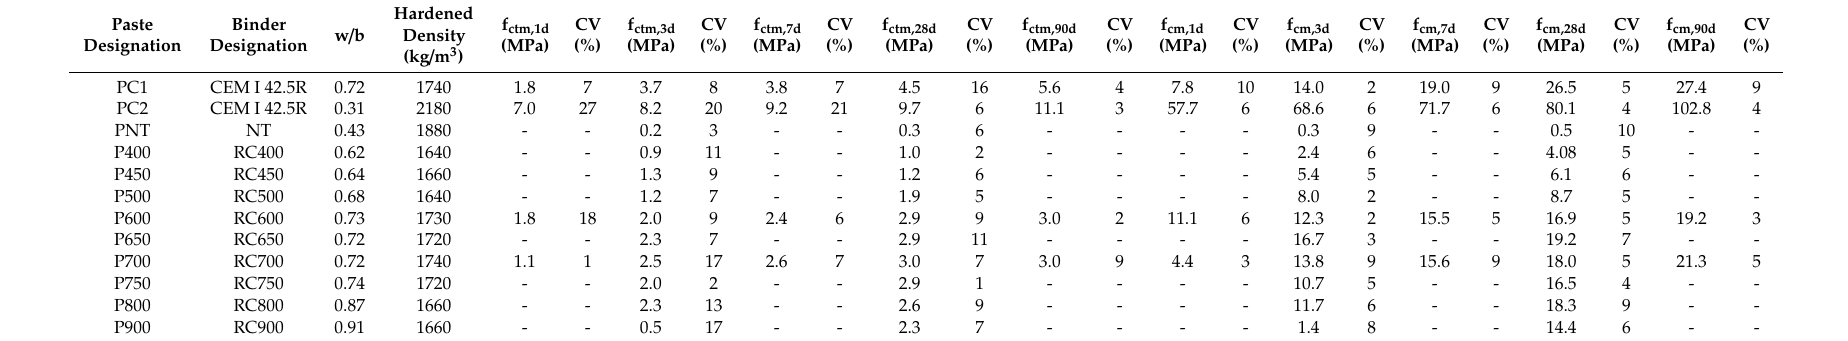
Table 6. Hardened properties of the studied